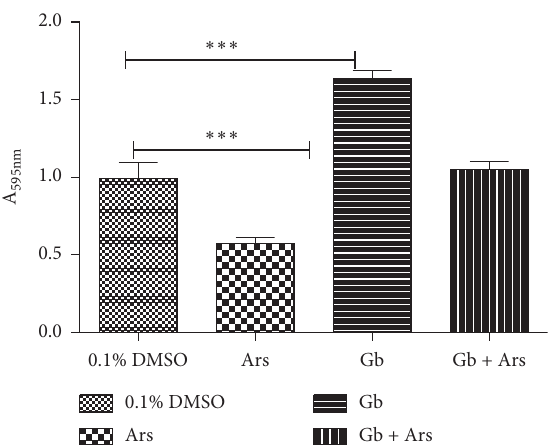
Figure 7: Butyrylcholinesterase inhibition assay of adult Javanese medaka treated with arsenic, crude extract, and arsenic and crude extract. The percentage of butyrylcholinesterase inhibition is shown versus concentration of the tested sample (arsenic, crude extract, and crudeextractandarsenic). ∗ P < 0 . 001, P < 0 . 01,and P < 0 . 05 represents significant different values of the control group and the group exposed to arsenic only, crude extract and arsenic, and crude extract only. The values represent mean ± SD from three ( n � 3) independent experiments.